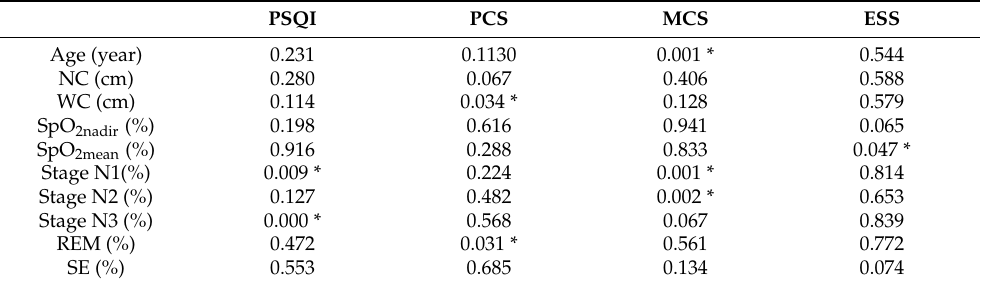
Figure 3. The ESS score for the interaction between OSAS severity and screened ADHD. * p < 0.05. Table 2. The crossing matrix for self-reported HRQoL in the three-way ANOVA analysis. Table 3. The univariate analysis of potentially associated factors for self-reported HRQoL.